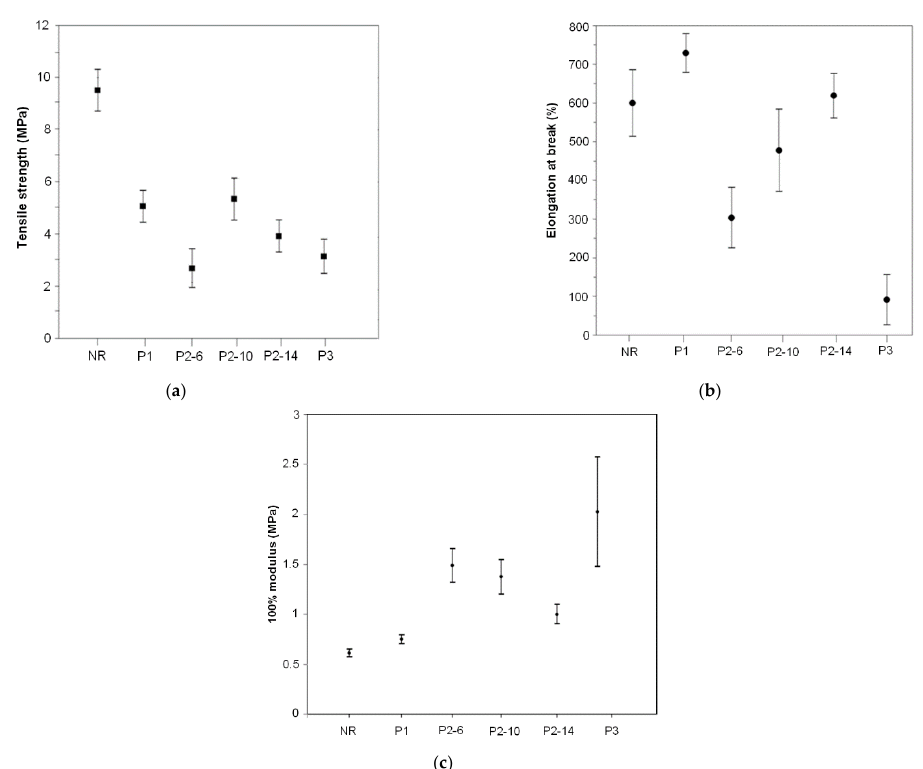
Figure 6. Tensile properties of the different rubber matrix composites: ( a ) tensile strength (MPa) (average and standard deviation), ( b ) elongation at break (%) (average and standard deviation), and ( c ) 100% modulus (MPa) (average and standard deviation).